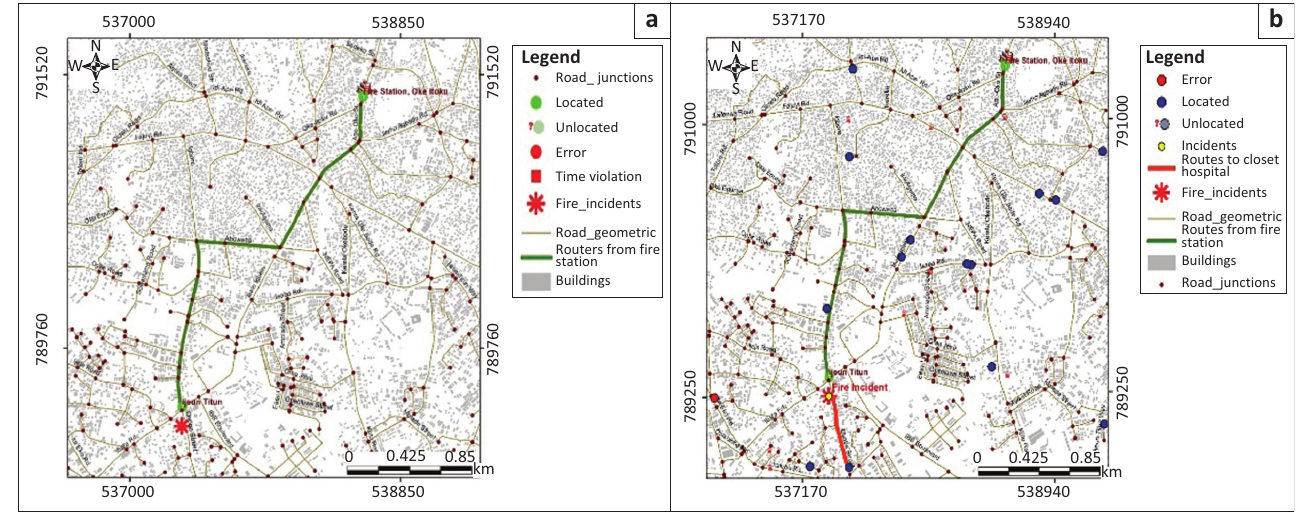
FIGURE 12: (a) Optimal route finding from a fire service station and (b) closest hospital to a fire event point.